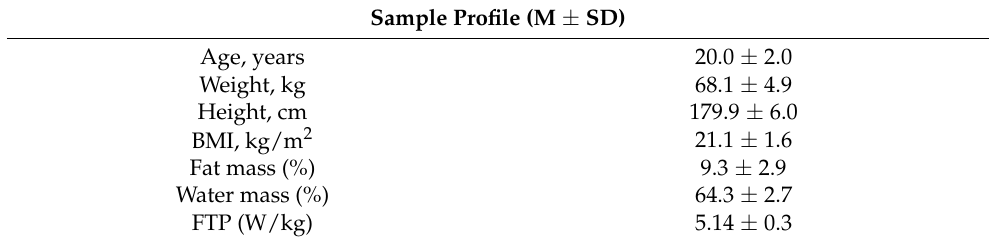
Table 1. Anthropometric characteristics of the cyclists (means ± standard